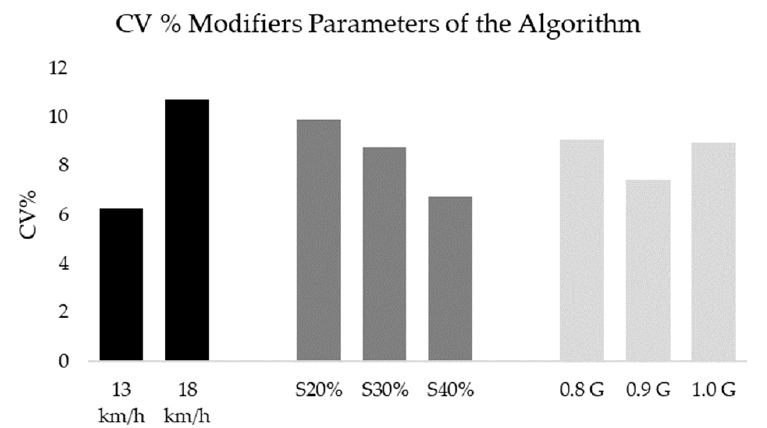
Figure 5. %CV between devices when the combinations were grouped by speed and modifier pa- rameters.